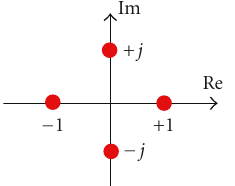
Figure 2: Lag coe ffi cients taken on the real and imaginary axis.